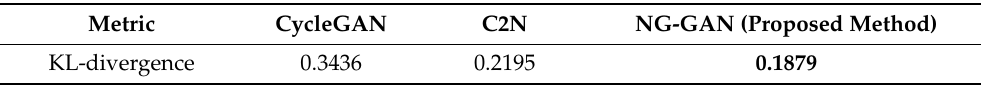
Table 2. Average values of Kullback–Leibler (KL) divergence between generated and real noisy images.